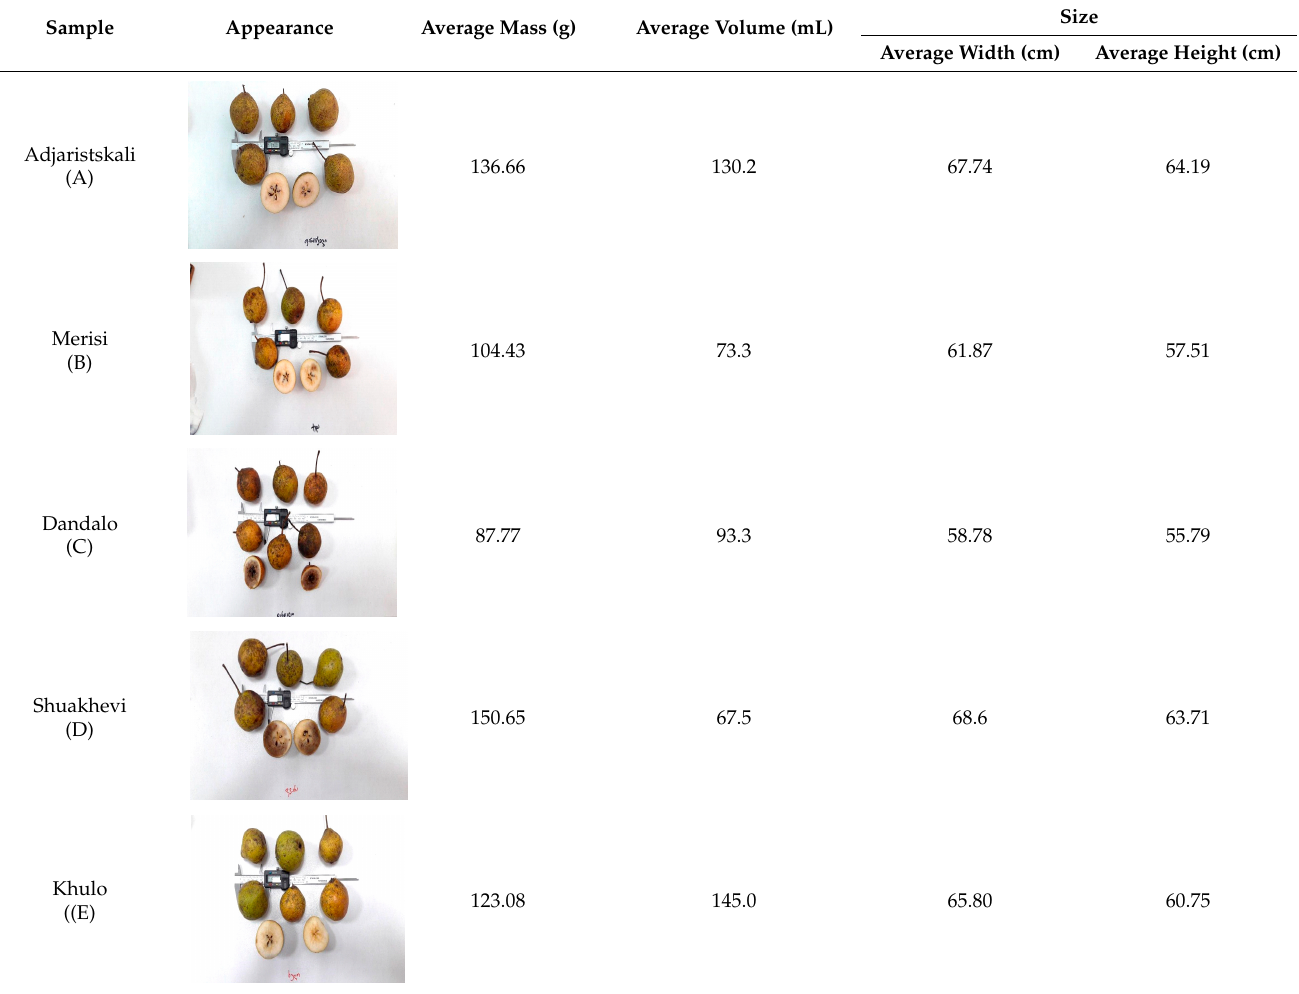
Table 1. Khechechuri pears collected from different villages with their respective description and characteristics. The fruits were all green in colour with black spots.